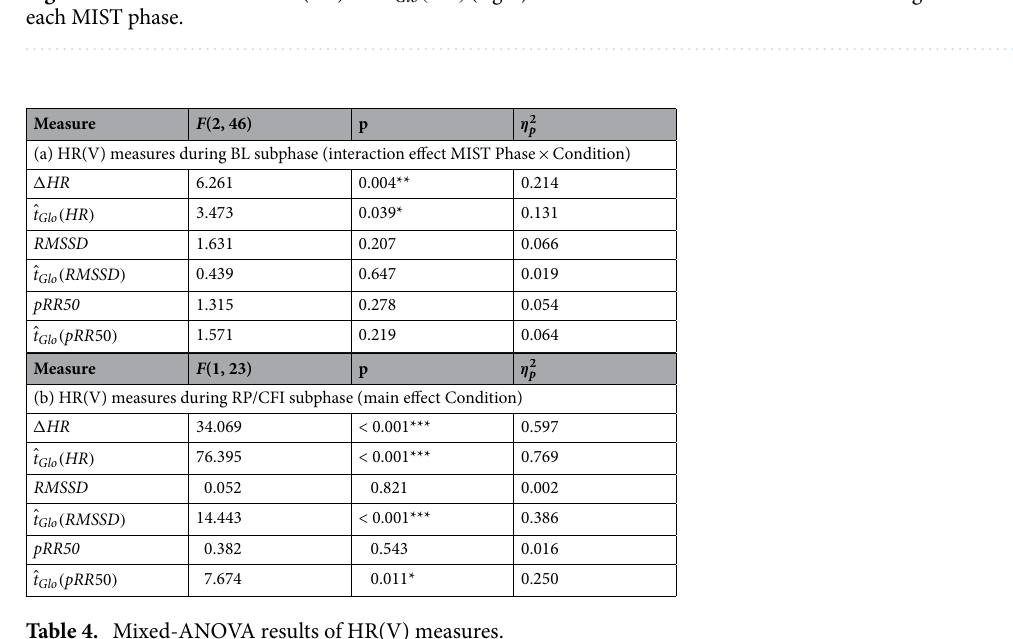
ˆ t Glo ( HR ) (right) between Control and CFT condition during BL for